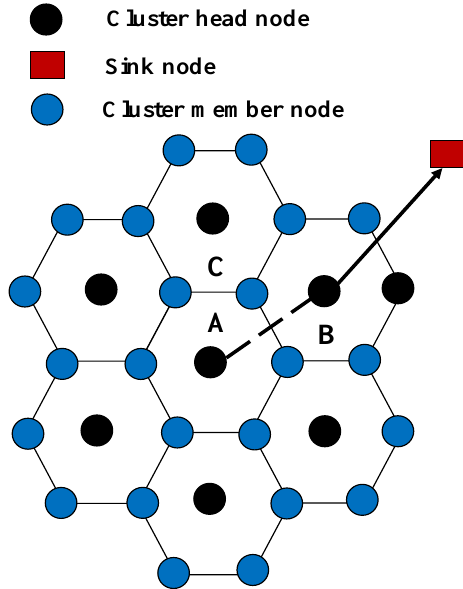
Figure 4. Cooperative data transmission between two CHs in the protocol.